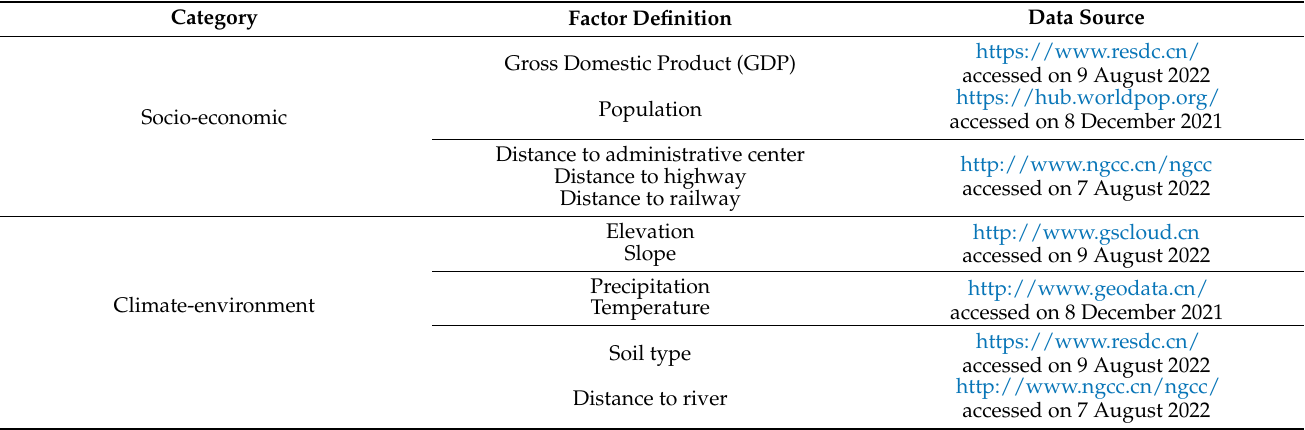
Table 1. LUCC driving